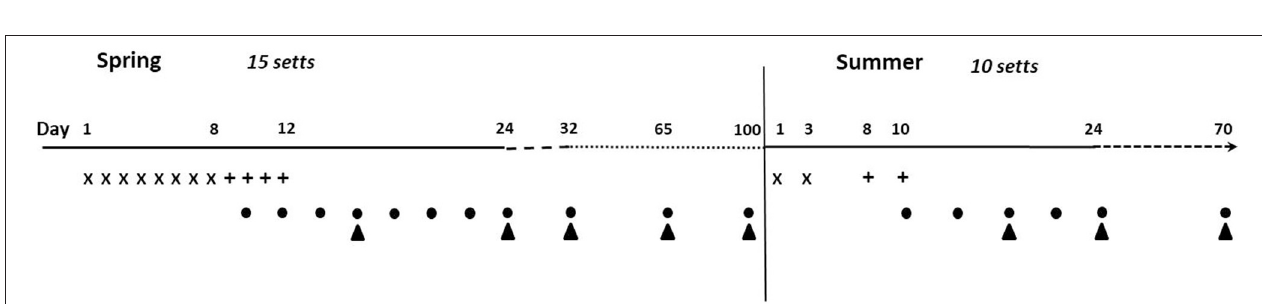
FIGURE 2 | Bait produced by Connovation Ltd. (Manukau, New Zealand) used in the study. On the left picture (by Rémi Schmitd), the palatable part (or PT made of peanut butter, cereal, and sugar) appears in red as it also contains Rhodamine B. The white part corresponds to the hardened peanut oil (HPO) where the vaccine, when present, may be inserted in the center. Right picture (by Matthieu Colombe): hair trap and baits deployed in the hole of a badger sett. These baits were previously packed within an YPBFERAL® paper bag.